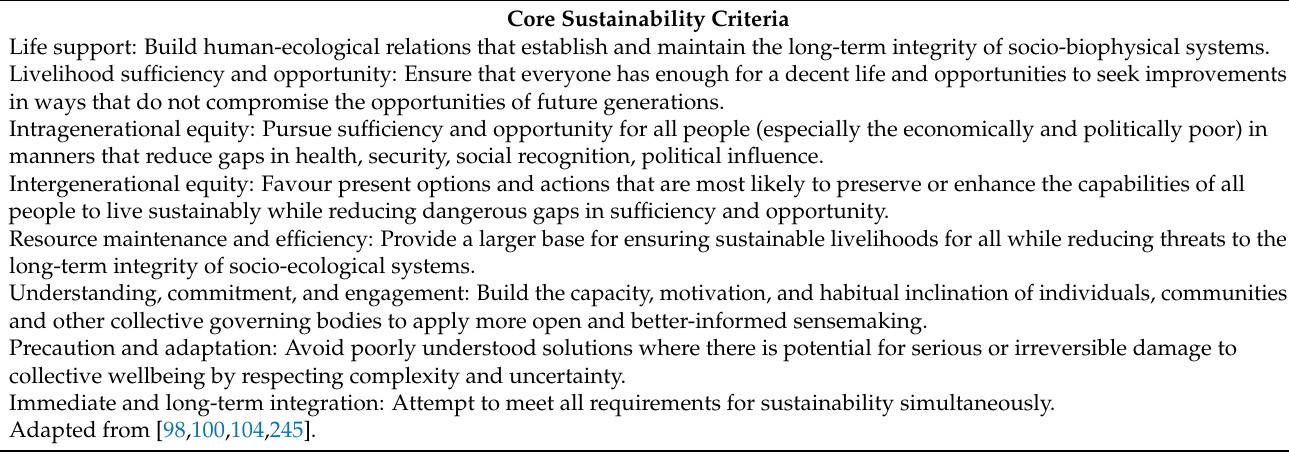
Table 1. Core Sustainability